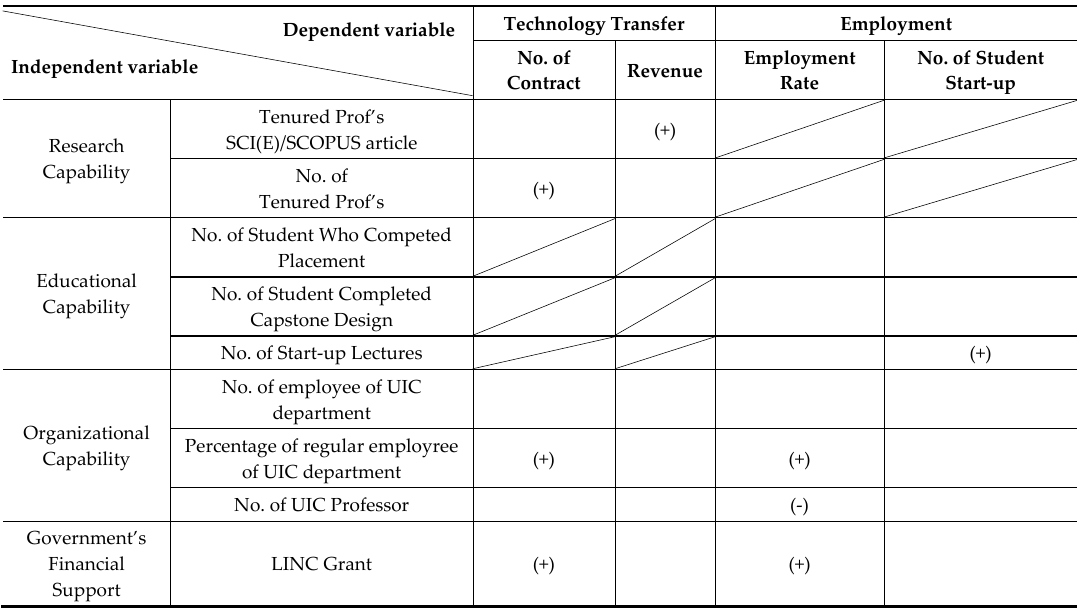
Table 2. Analysis result.